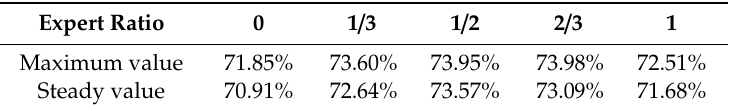
Table 5. Statistical results of the series similarity.